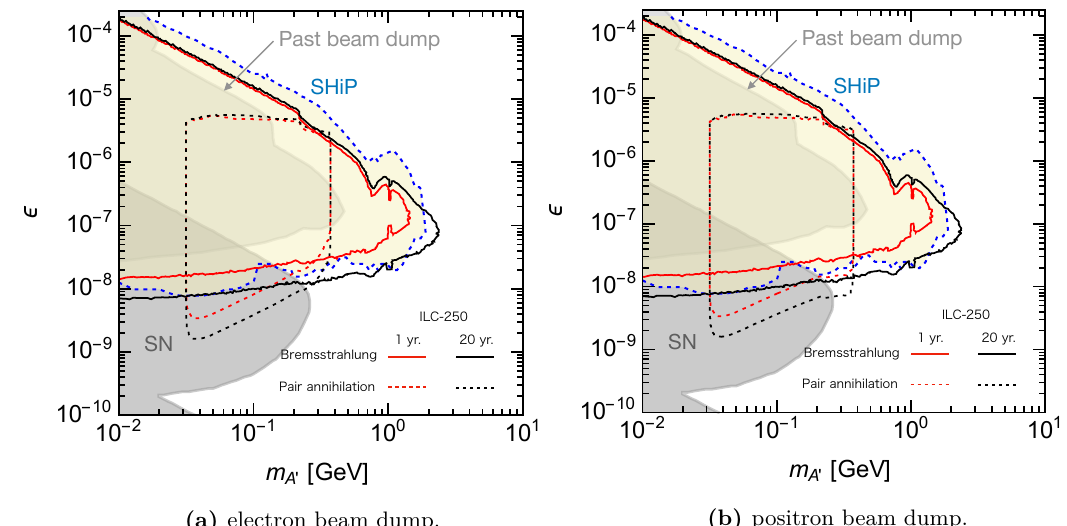
Figure 3. The red and black curves show the bounds of sensitivity for ILC-250 at 95% C.L. with 1- and 20-year statistics. The solid lines are the dark photon bremsstrahlung and the dotted lines the dark photon production from the pair annihilation of positrons. The light-gray shaded region is excluded by past beam dump experiments at 95% C.L. [22] The dark-gray shade shows the region excluded by SN 1987A [23], while the yellow shade shows the sensitivity of the SHiP experiment